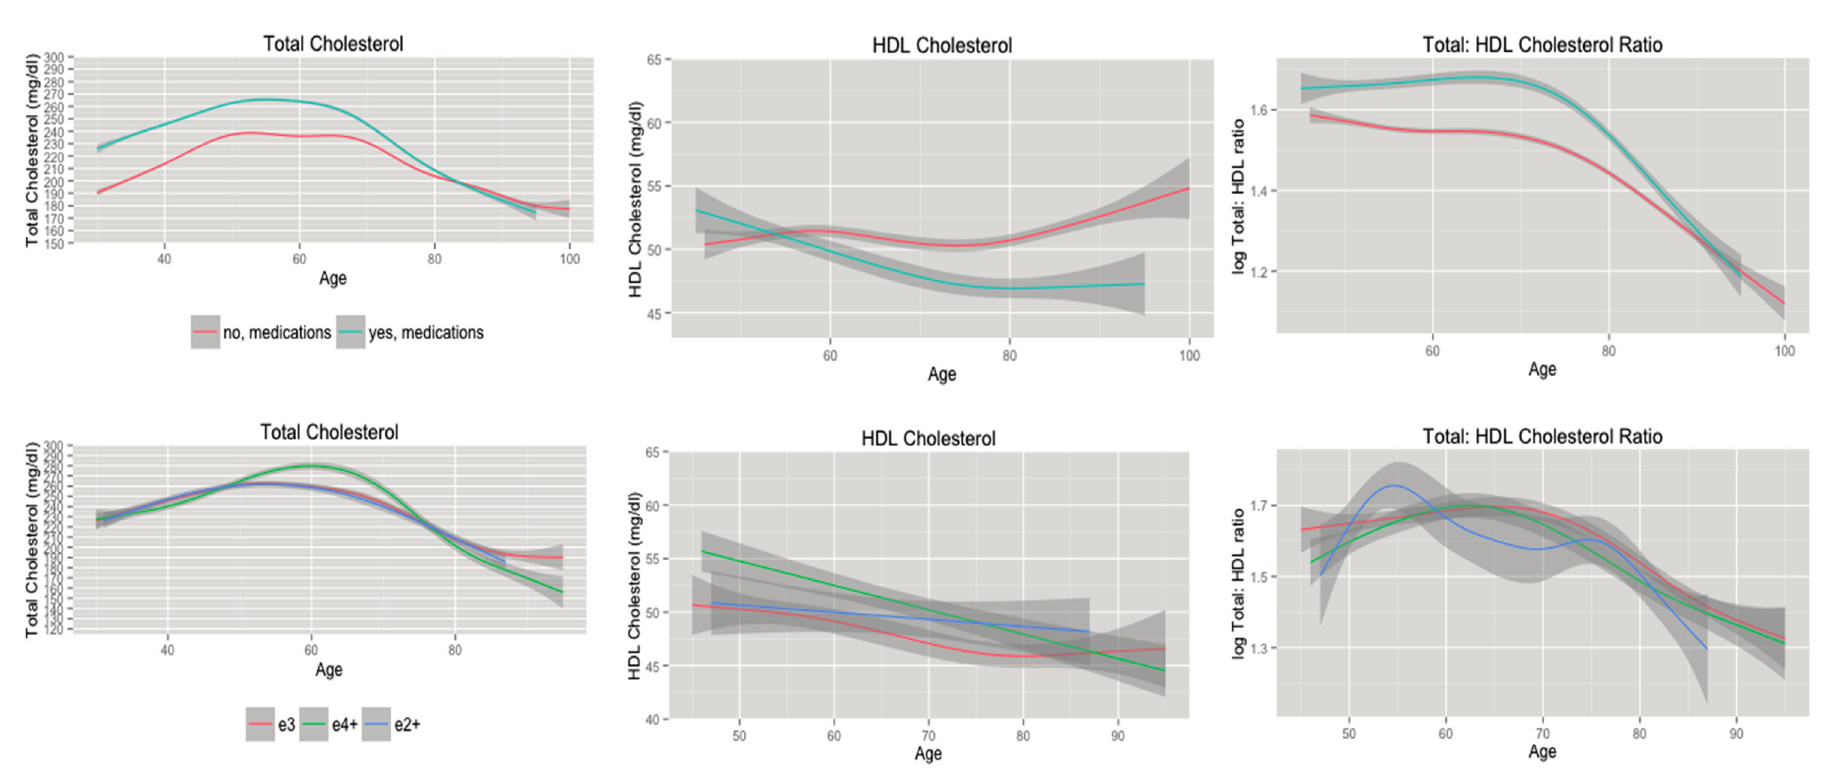
Figure 2. Cholesterol trajectories stratified according to history of using cholesterol-lowering medications, and APOE allele status adjusting for age of first using cholesterol-lowering